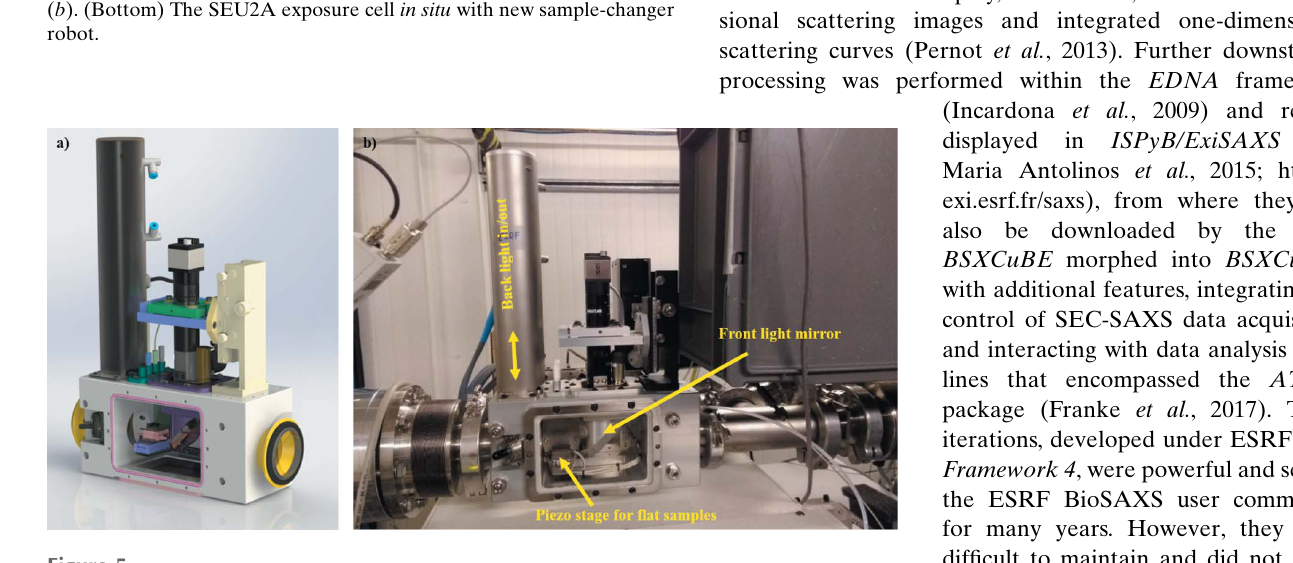
Figure 5 CAD design of the microfluidics-compatible SEU2B exposure cell ( a ) and SEU2B in situ ( b